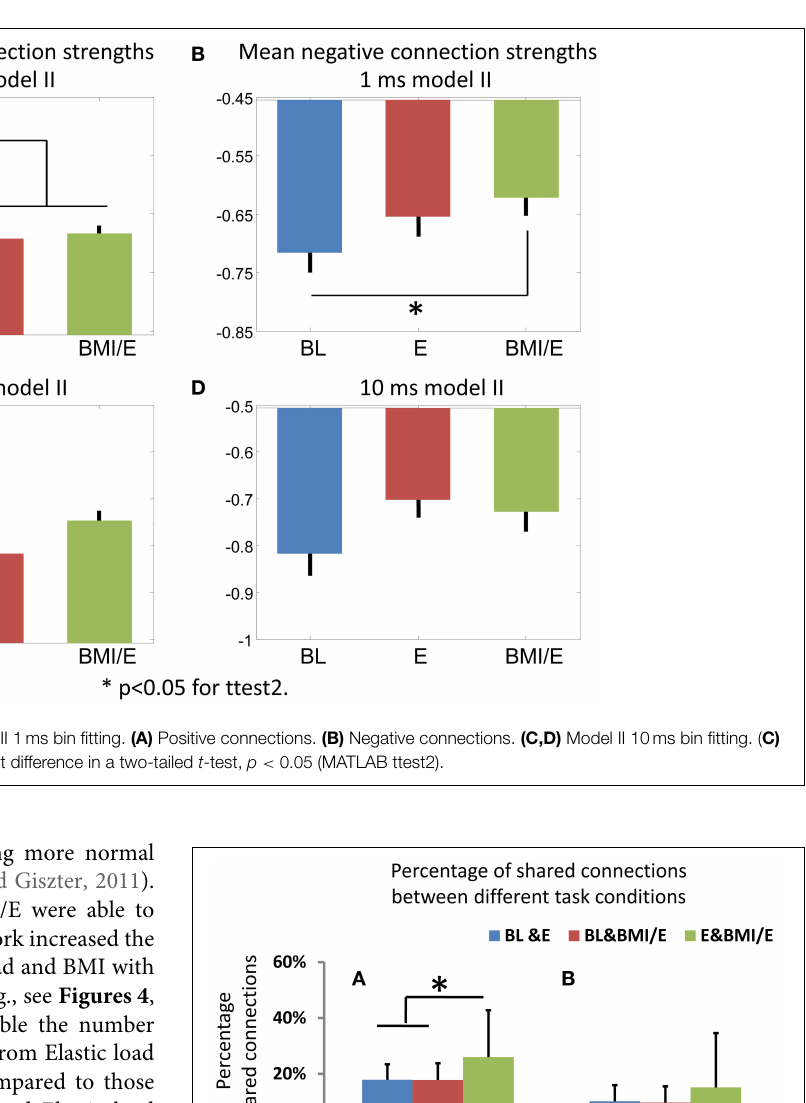
FIGURE 7 | (A) Shared connections between networks obtained in two conditions. On either 1ms or 10ms binned timescales, the networks showed significant differences in connectivity between two conditions (BL vs. E, BL vs. BMI/E and E vs. BMI/E) using binomial tests. However, with 1ms binning there was a significantly higher percentage of shared connection between E and BMI/E than that between any other two conditions (BL vs. E and BL vs. BMI/E, indicated by * , two-tailed t -test, p < 0 . 05 , MATLAB ttest2). (B) For the 10ms binning there was no significant difference in the percentage of shared connection between any paired conditions, and percentages of shared connections were significantly lower than in the 1ms binned GLM